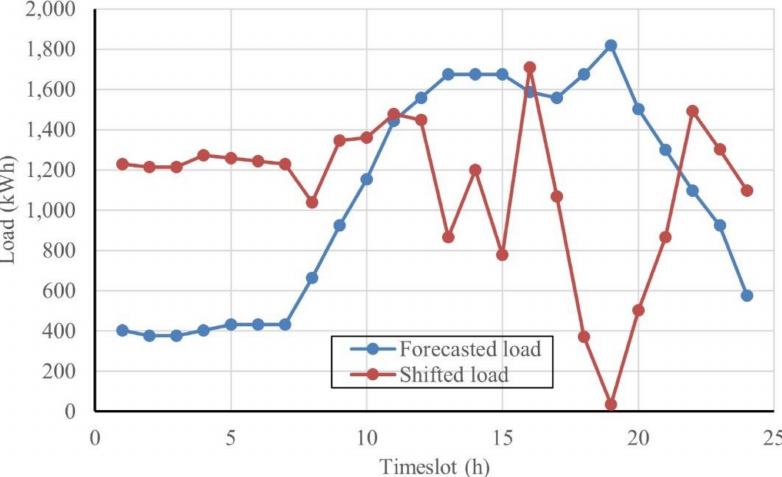
Figure 21. Hourly commercial load before and after DSM using the centralized algorithm RTP-SBY.